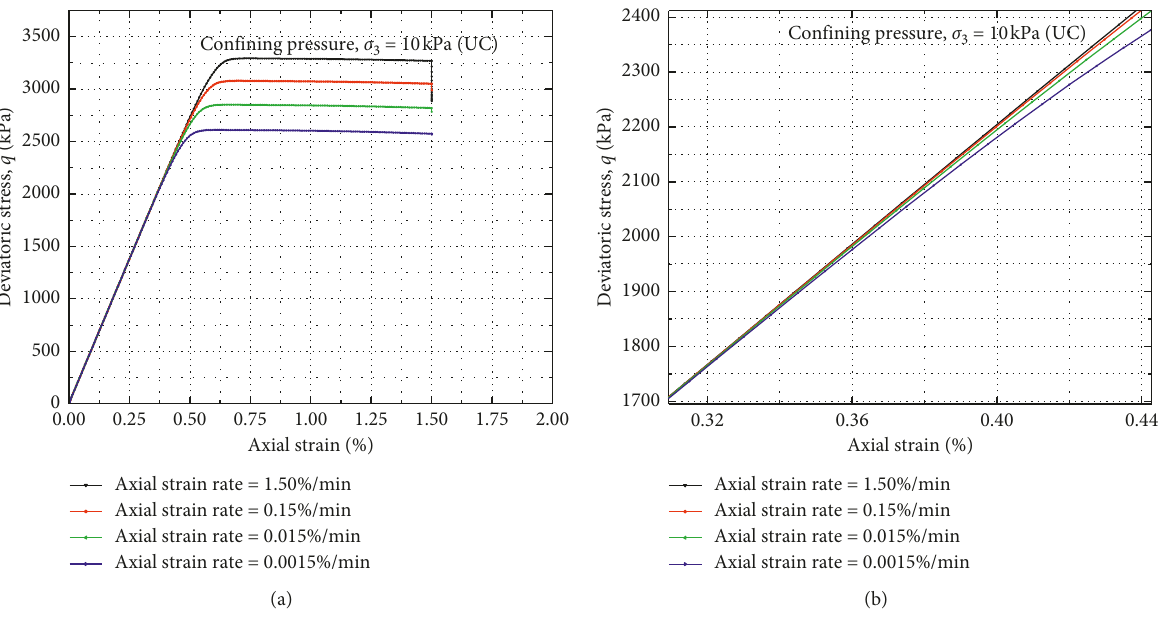
Figure 7: Deviatoric stress versus axial strain (%) for various strain rates under a single confining stress of 10kPa. (a) Displacement control analysis is done. (b) Displacement control analysis is done in the compression direction (zoomed up figure of Figure 7(a)).